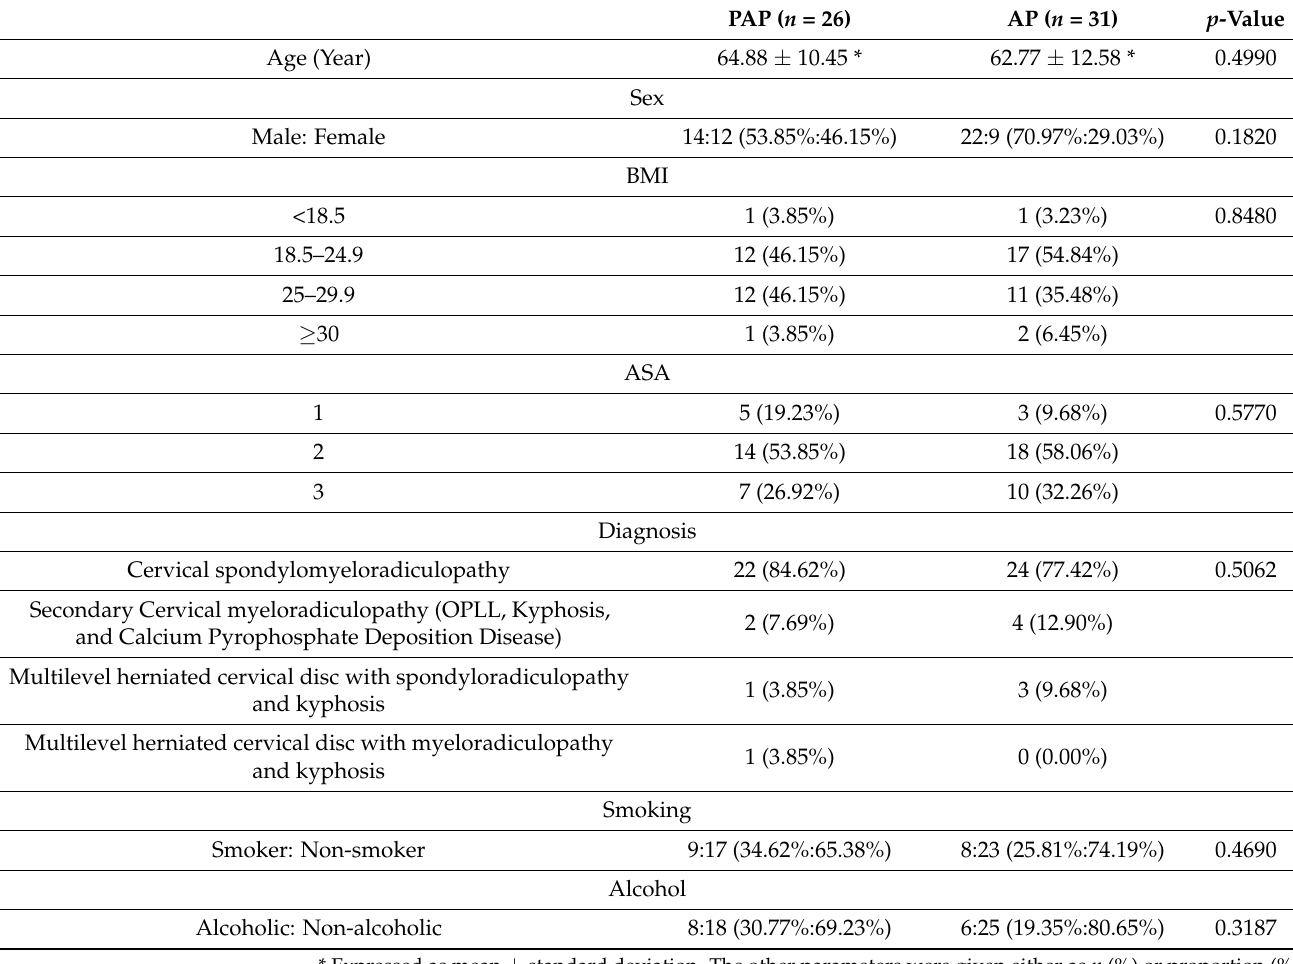
Table 1. Demographic profiles of staged AP and PAP patients.